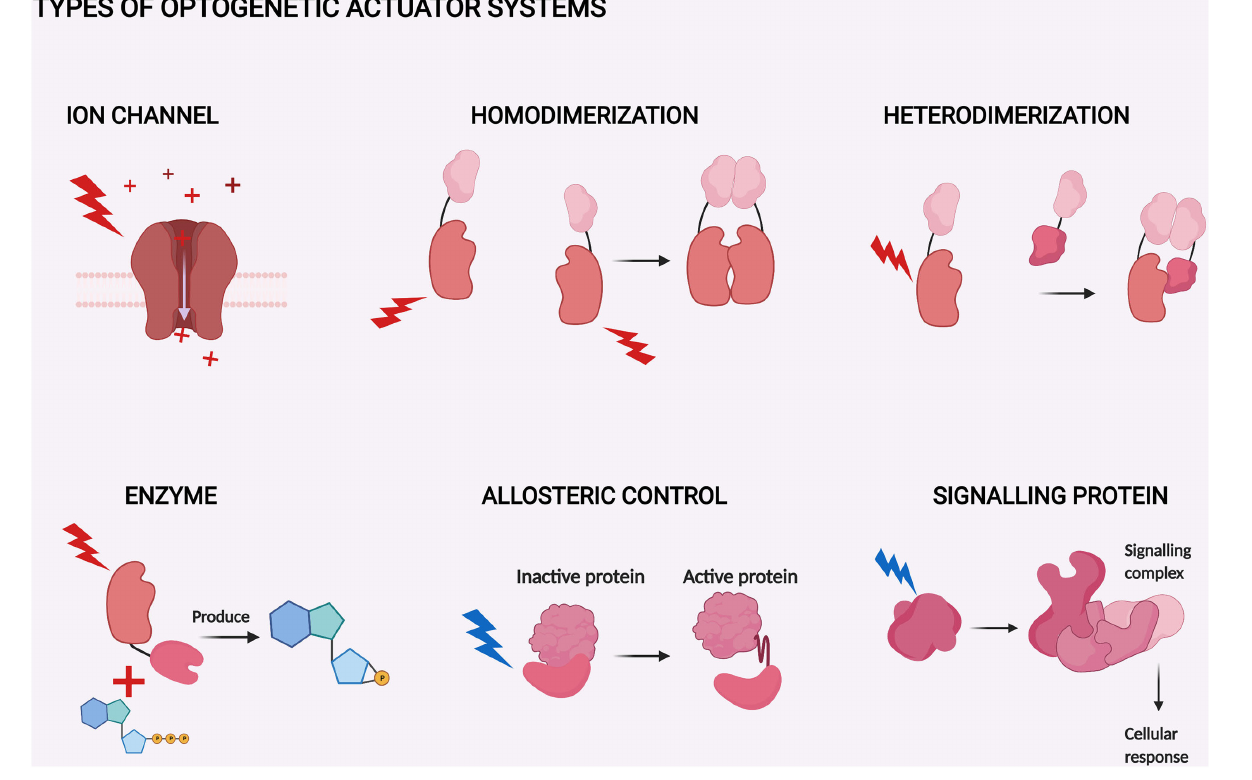
FIGURE 1 | Types of optogenetic actuator systems. The six major actuator systems and the example studies related to them pertain to ion channels (Klapoetke et al., 2014), homodimerization (Schmidl et al., 2019), heterodimerization (Kaberniuk et al., 2016), enzyme activity (Gasser et al., 2014), allosteric control (Strickland et al., 2008), and signaling proteins (Kim et al., 2005). The components of the systems with similar function are depicted with a similar shape. The shapes are not accurate depictions of the actual proteins and are not to scale. The illumination of each actuator is depicted as lightning and colored according to each system. The figure was created with